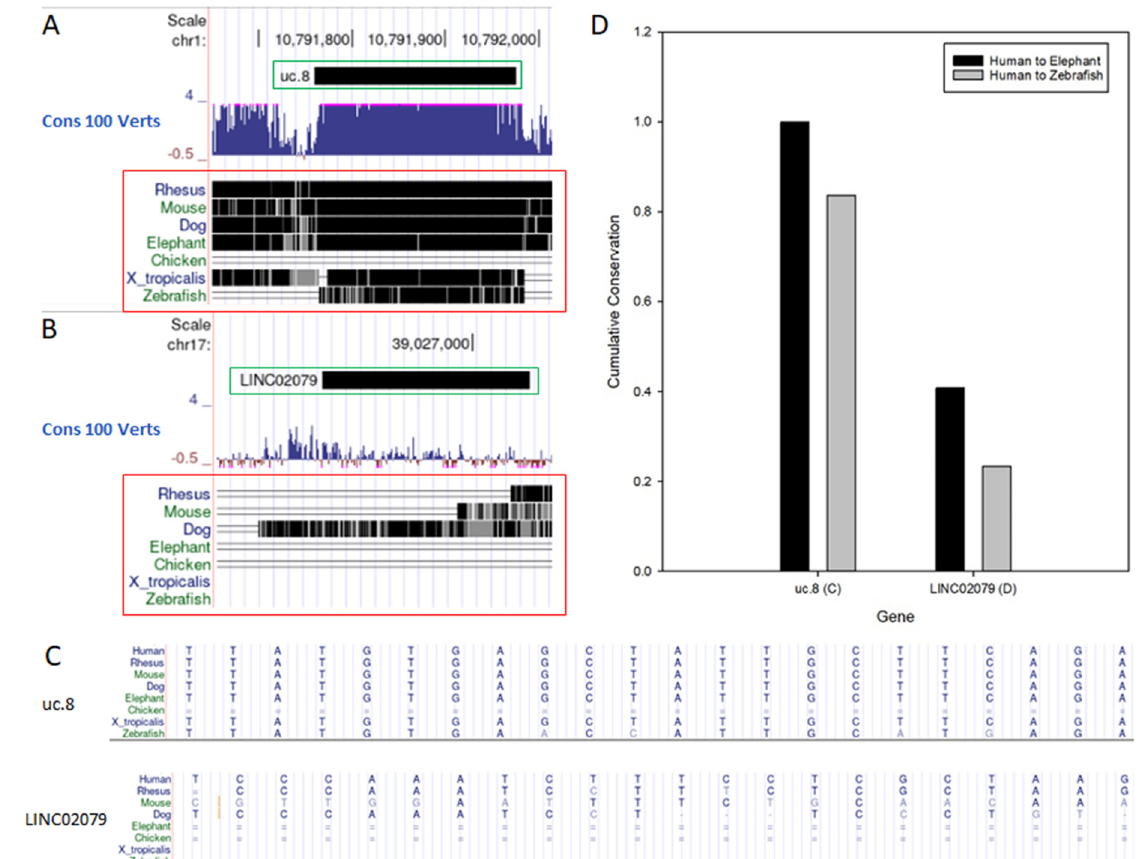
Figure 1. TUCRs represent highly conserved lncRNAs. LncRNAs are typically poorly conserved, while TUCRs are 100% conserved in human, mouse, and rat genomes. The TUCR uc.8 (( A ), green box) is highly conserved (( A ), red box) compared to the lncRNA LINC02079 (( B ), green box), which is more poorly conserved (( B ), red box). Nucleotide conservation is highlighted for uc.8 and LINC02079 ( C ) and quantified ( D ).